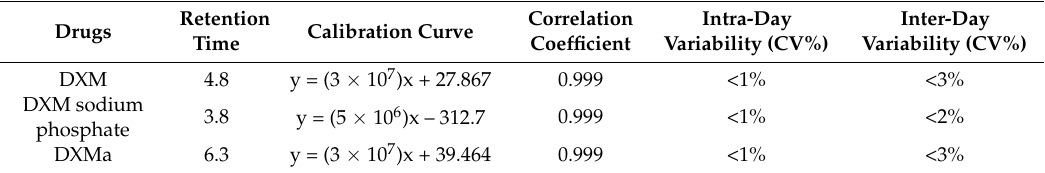
Table 1. Calibrations curve, retention time, correlation coefficient and variability of DXM, DXM sodium phosphate and DXMa quantitative determinations by